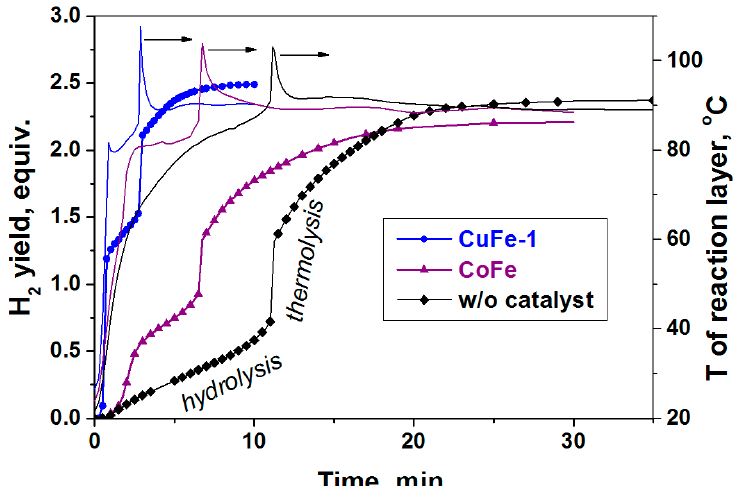
Figure 4. The influence of ferrites on hydrogen generation (symbol + line) and temperature of reaction layer (line) during the catalytic hydrothermolysis of NH 3 BH 3 at external heating of reactor at 90 ◦ C and a molar ratio of H 2 O/NH 3 BH 3 =